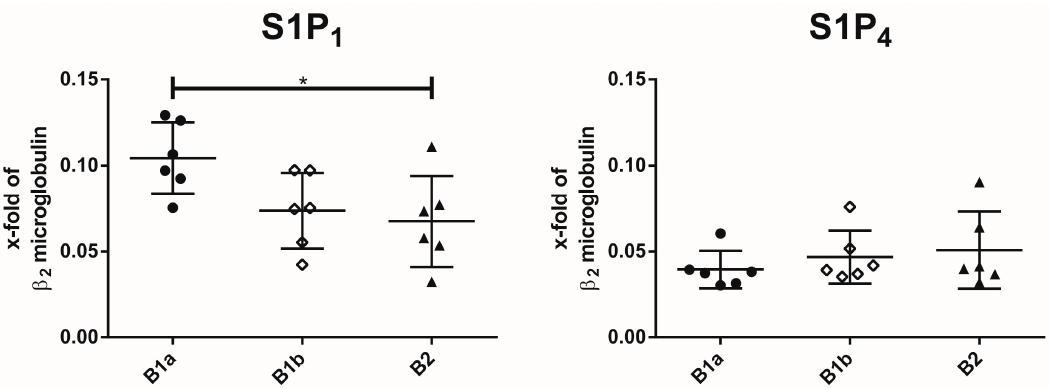
Figure 1. Expression of sphingosine-1-phosphate (S1P) receptor subtypes S1P 1 and S1P 4 in peritoneal B cell subpopulations. S1P receptor expression analysis was determined by real-time polymerase chain reaction (qPCR) on peritoneal B cell populations. Gene expression was normalized to β 2-microglobulin. Values represent the mean and standard error of the mean of n = 6 animals per group. * p < 0.05.